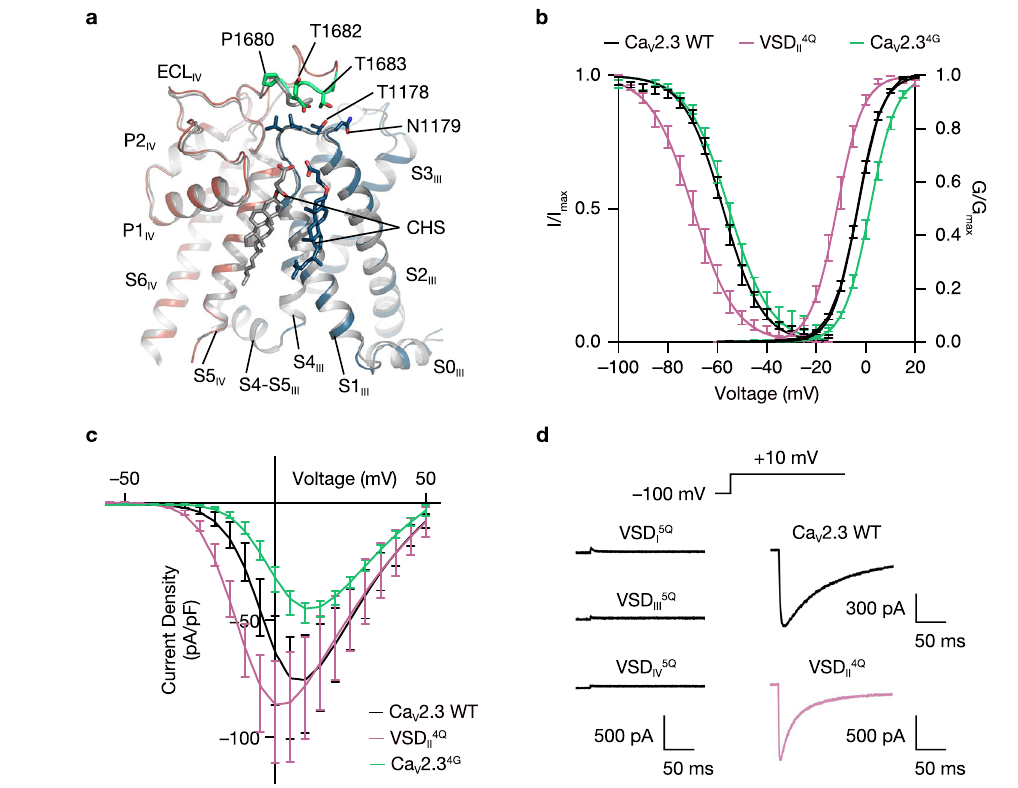
in 10-mV increments. To determine inactivation curves, cells were stepped from a holding potential of – 100mV to pre-pulse potentials between – 100 and – 15mV in 5-mV increments for 10s. Activation curve, Ca V 2.3 WT, n =14; VSD II 4Q , n =7; Ca traces of the Ca V 2.3 WT, VSD I 5Q , VSD II 4Q , VSD III 5Q , and VSD IV 5Q , elicited by a 200-ms test pulse at +10mV. Data are presented as mean±SEM. n biological independent